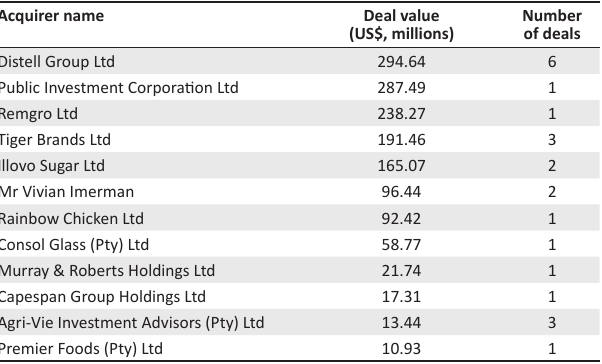
TABLE 13: Agricultural mergers and acquisitions outflows from South Africa by company, 2003–2014.